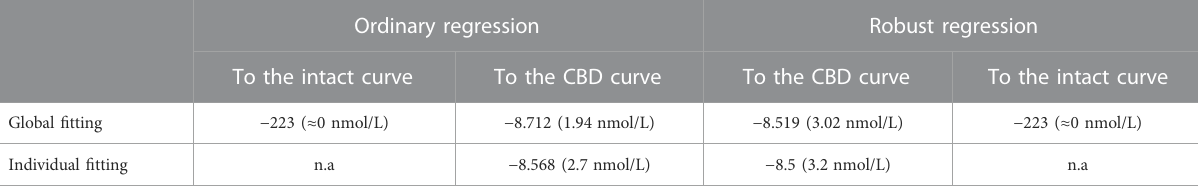
TABLE1Thelogc x (andc x )valuesobtainedwiththereceptorialresponsivenessmethod(RRM)performed bycombiningtwoindependentregressionsettings: individual vs . global, and ordinary vs . robust. Ordinary regression